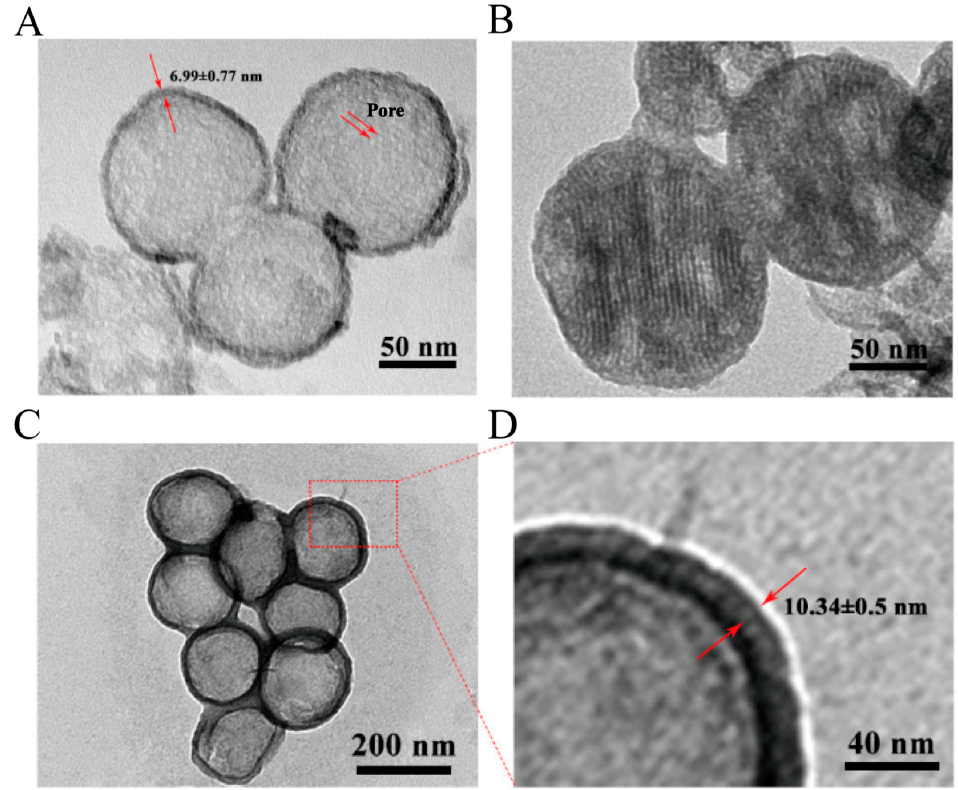
Table 1. Diameter (nm), zeta potential (mV), and PDI values of samples.